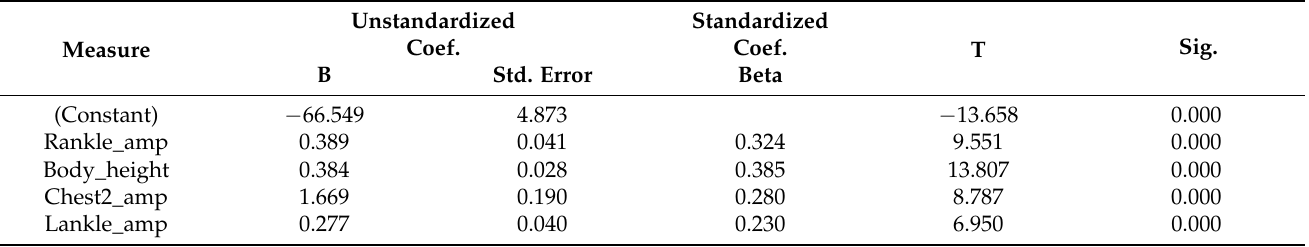
Table 9. Results of Stepwise Regression of SD_hip (Amp. Fast).